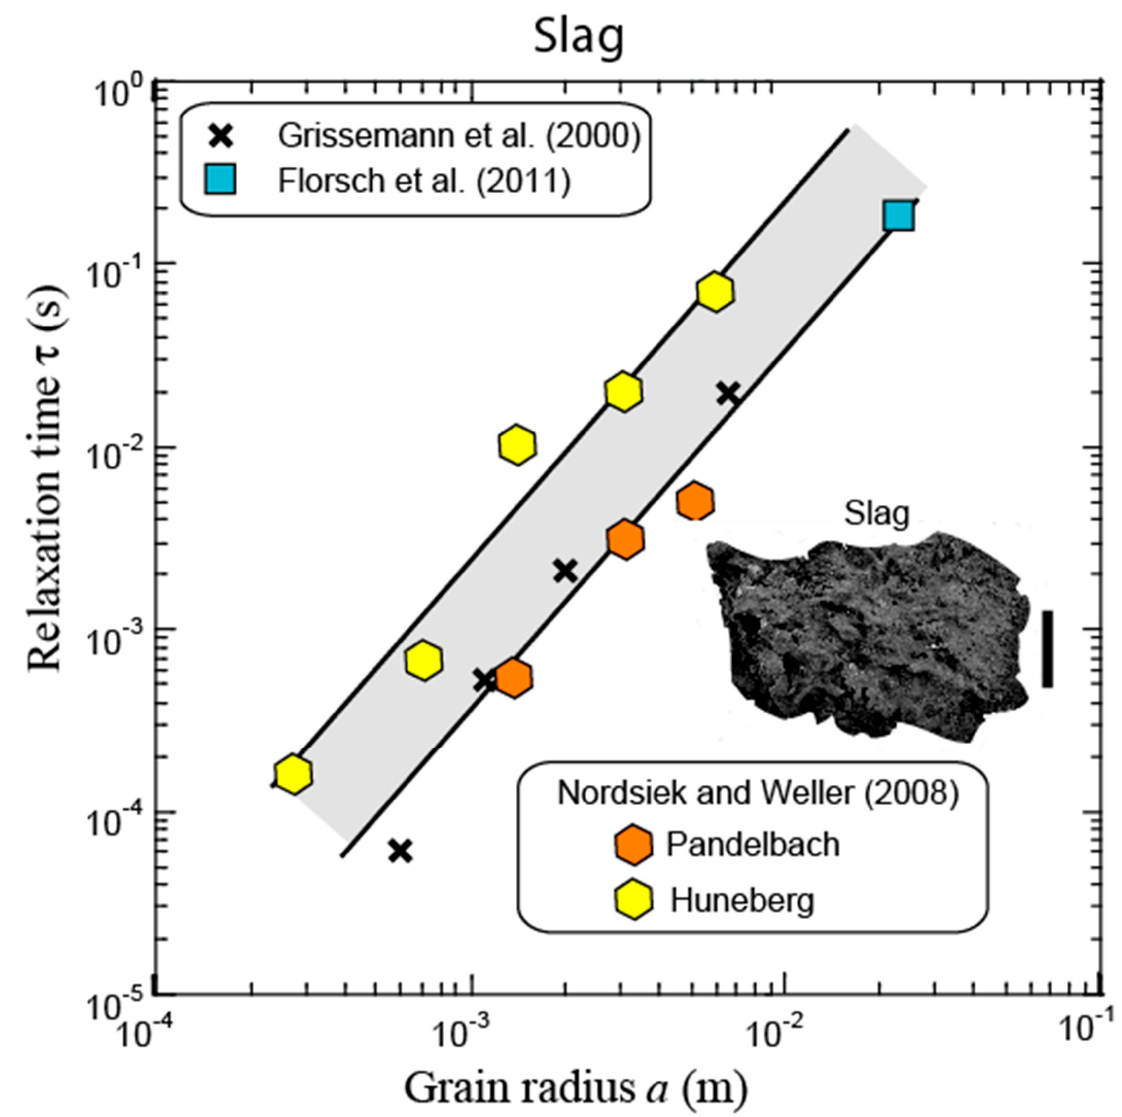
Figure 16. Time constant ( τ = 1/ ( 2 π f peak ) ) for the complex conductivity model versus the radius of the metallic particles for iron slag, and f peak is the critical frequency that corresponds to the maximum of the phase. Experimental data from Nordsiek and Weller (2008) [20], Grissemann et al. (2000) [94], and Florsch et al. (2011) [17]. In the case of the data from Nordsiek and Weller (2008) [20], we use the relationship τ = τ ρ ( 1 − M ) 1/2 c to convert the Cole–Cole time constant for the complex resistivity ( τ ρ ) into the time constant ( τ ) that corresponds to the peak of the phase. The diffusion coefficient ( D ) is in the order of 1 × 10 − 3 m 2 s − 1 , according to the grey band that corresponds to the model. The picture shows a block of slag (vertical bar: 10 cm) from the Castel-Minier site (Aulus-les-Bains, France, Courtesy from F. Téreygeol).